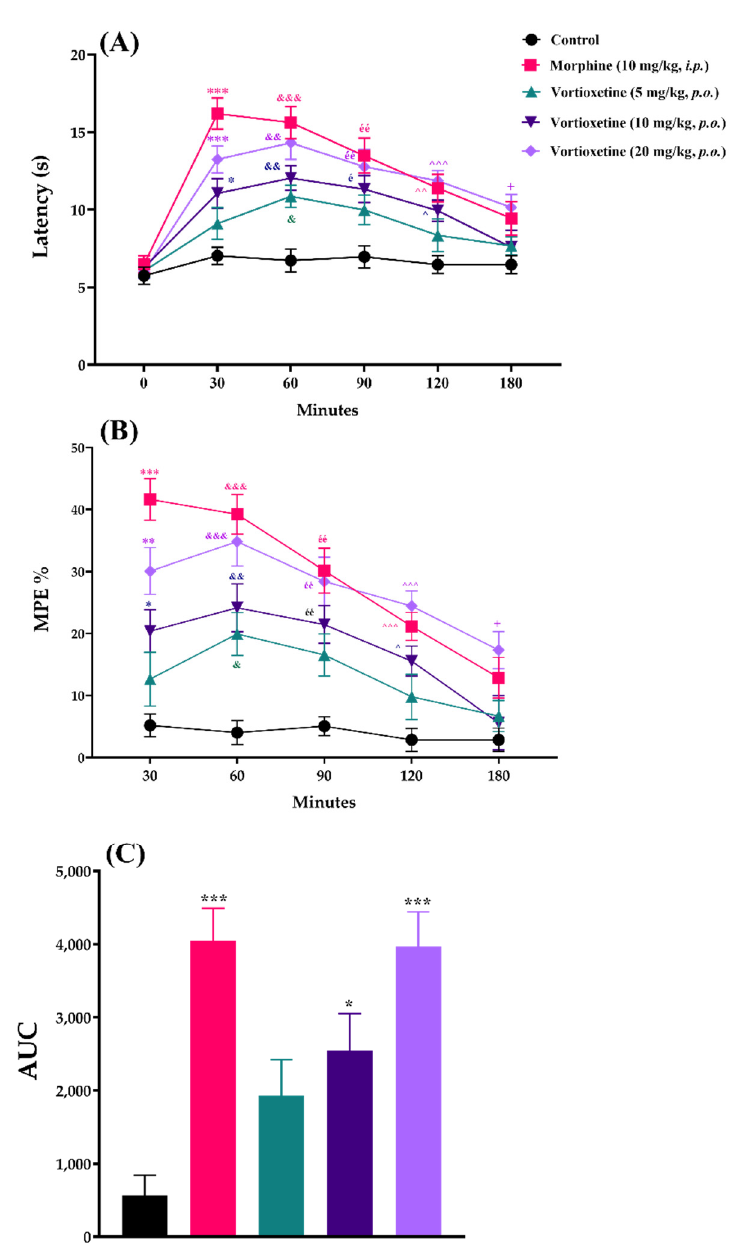
Figure 4. The effects of morphine (10 mg/kg, i.p. ) and vortioxetine (5, 10 and 20 mg/kg, p.o.